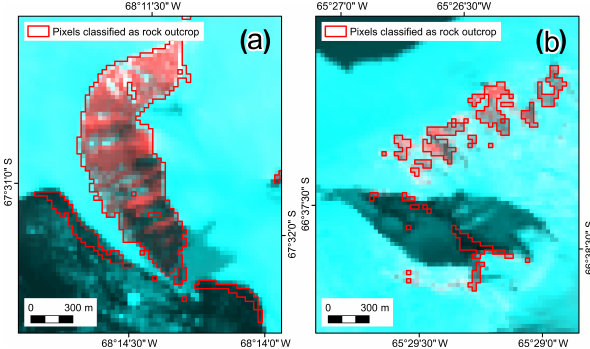
Figure 12. Examples of the new methodology’s limitations, com- paring the new dataset with false-colour Landsat 8 images. The band combination (red: SWIR2; green: blue; blue: blue) is chosen to accentuate rock, snow and seawater distinctions, with red pix- els representing rock, turquoise pixels for snow and dark green to black pixels for seawater. (a) An example of seawater near calving ice classified as rock (later removed manually). (b) An illustration of conservative outcrop extent estimation using the new technique. This is a result of the mildly conservative threshold values that had to be chosen to allow the automated analysis of so many tiles over the area of an entire